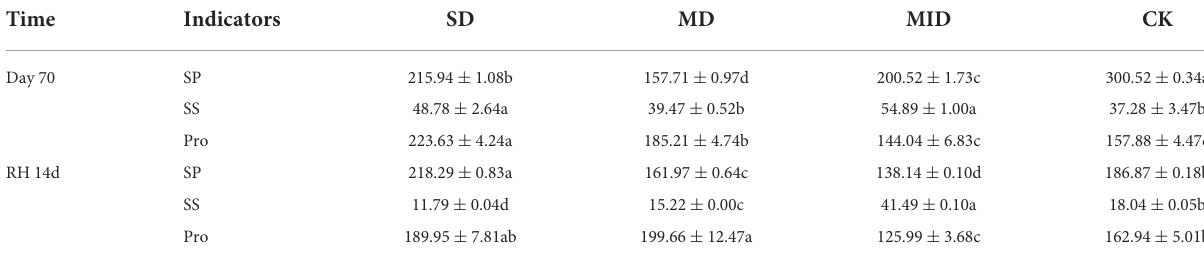
TABLE 3 Osmotic regulator substance content in leaves of A. selengensis after drought (Day 70) and rehydration (RH, 14 d). Time Indicators SD MD MID CK